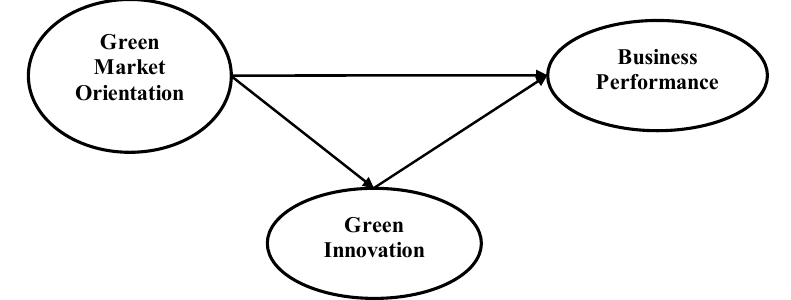
Figure 1. Conceptual research framework.